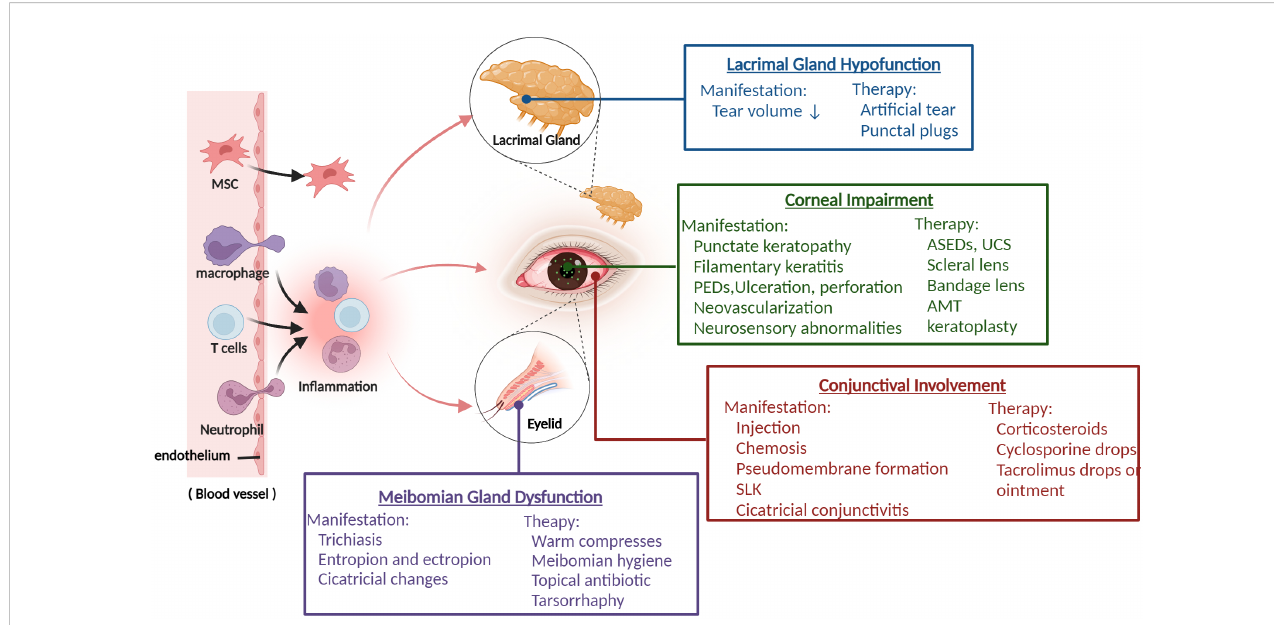
FIGURE 1 The overview of ocular GVHD and clinical management. Donor-derived immune cells (T cells, macrophage, neutrophil) cross the blood vessel barrier into the eye and drive the ocular in fl ammatory response, which leads to ocular tissue damage including lacrimal glands, meibomian glands, corneal, conjunctival and presents various related clinical characteristics. Based on the manifestations of different ocular impairments, it helps clinicians to take appropriate treatment measures. PEDs, persistent epithelial defects; ASEDs, autologous serum eye drops; UCS, umbilical cord serum; AMT, amniotic membrane graft; SLK, superior limbal keratoconjunctivitis. (Created with